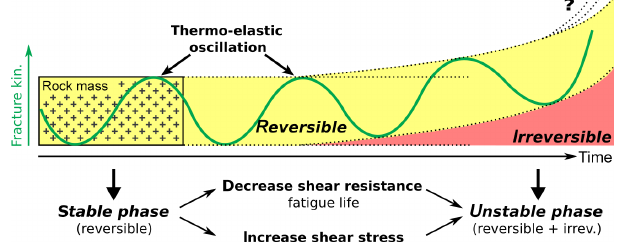
Figure 2. Evolution of a permafrost-affected rock mass with persis- tent thermoelastic oscillations: initially reversible displacement of rock mass can develop an additional irreversible component either by an increase in shear stress or by a decrease in shear